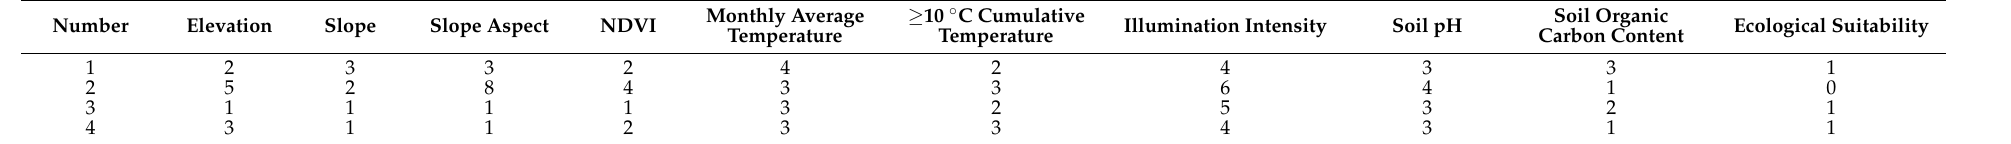
Table 4. Sample data